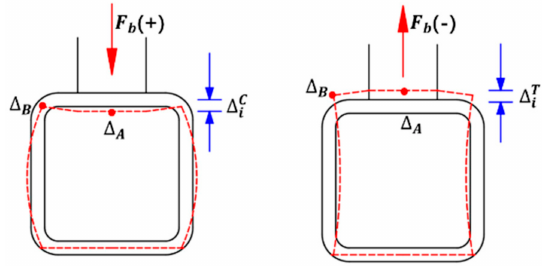
Figure 35. Deformation model of converged section